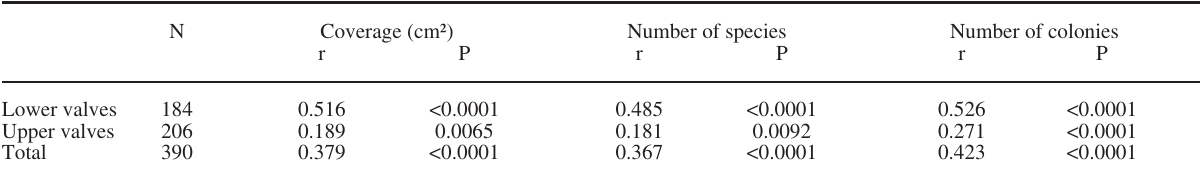
Table 2. – Relationship between valve area and bryozoan coverage, species richness and abundance. r: product-moment correlation coefficient. N